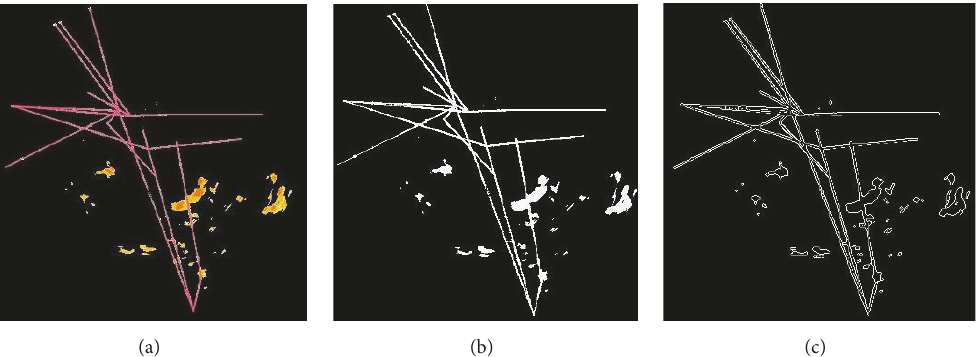
Figure 9: From (a) to (c): image after extracting the yellow elements, corresponding binary image, and contour lines (the red lines and white lines are route